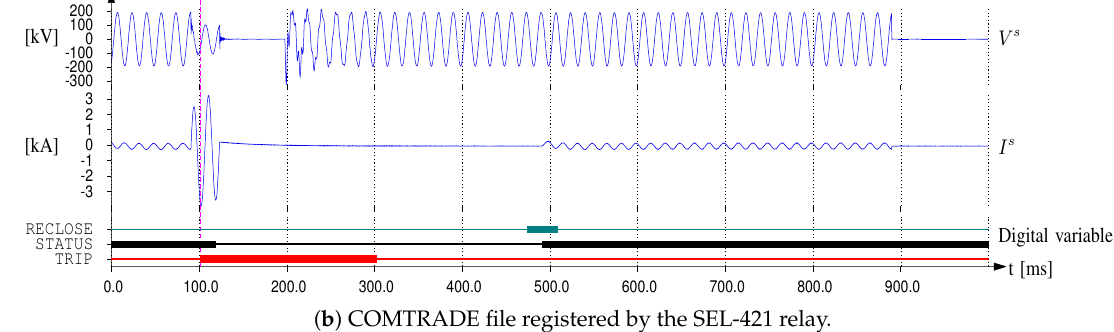
Figure 4. Test case for a single-phase-to-ground (AG) fault located 30 km from Bus 1 with R f = 0.01 Ω